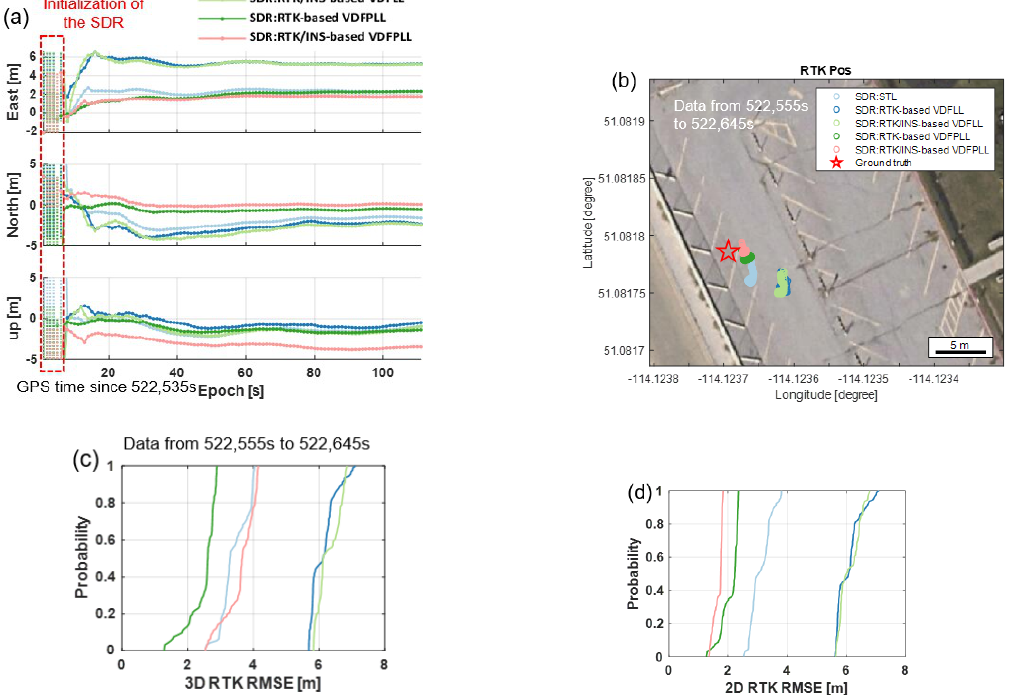
Figure 8. RTK position results and statistical analysis of different SDRs in the open-sky situation where dashed lines correspond to the outlier epochs. ( a ) RTK position errors ( b ) horizontal RTK results in Google Map ( c ) CDF curves of 3D RTK RMSE ( d ) CDF curves of horizontal (2D) RTK